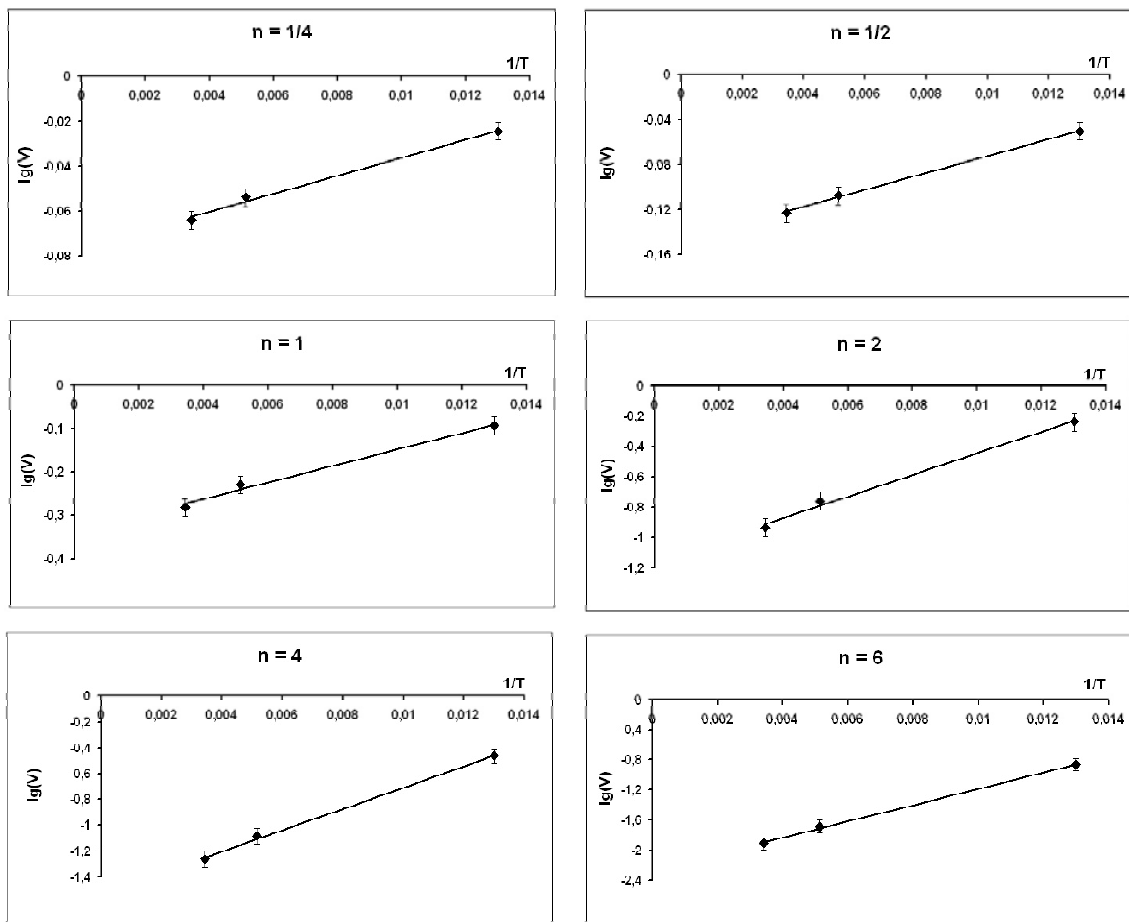
Fig. 4. Dependency graphs in the coordinates lg( V ) = f (1/ T ) after HPT for the crystalline Ti different values of n